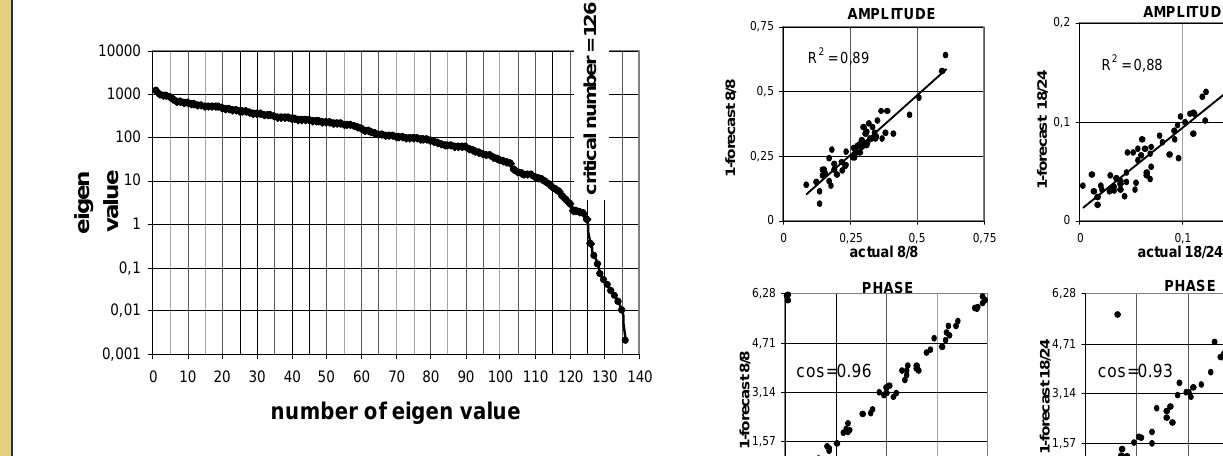
Fig. 1 Figure 1. An example of the eigen value spectrum of the ob- servability matrix A 0 A with use the H500-data observed at 572 ra- diosonde stations of the Northern Hemisphere, and with taking into consideration 136 spherical harmonics (a rhomboidal spherical har- monics truncation with maximal wave numbers M = 8, N = 22). Figure 2. Examples of the relationships between actual and fore- casted (1-day lead time) amplitudes and phases of the observable ( m = 8, n = 8) and unobservable ( m = 18, n = 24) waves in H500- flields of the Northern Hemisphere. Squared correlation between actual and forecasted amplitudes, and mean values of the cosine of the actual and forecasted phase di ff erences are indicated as quanti- tative measures of the 1-day forecast